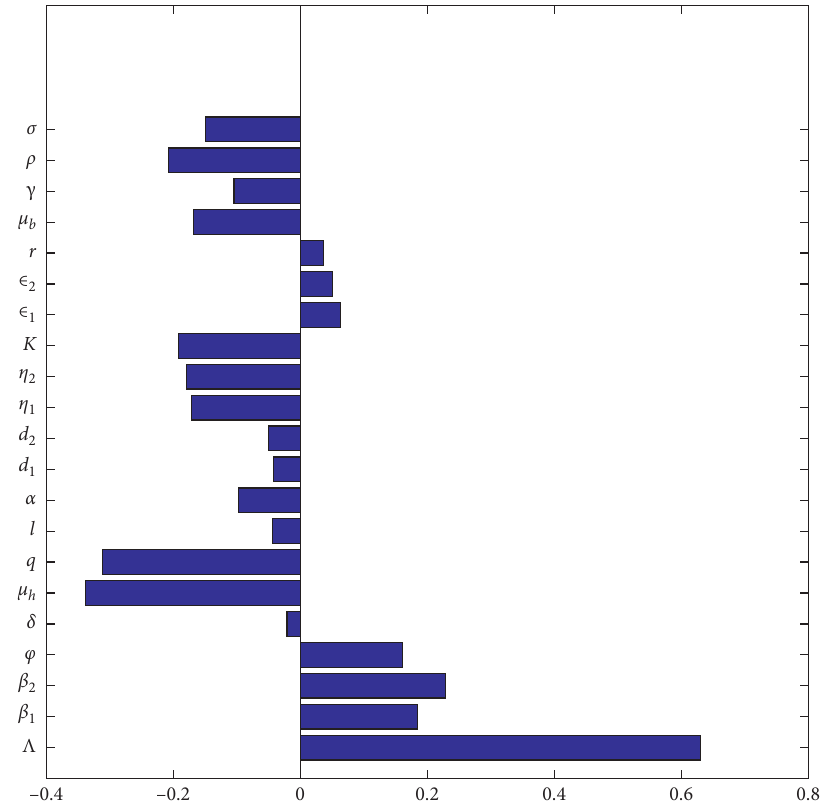
Figure 6: Tornado plots of PRCC of parameters that influence model (2) generated using parameter values in Table 4. Parameters with PRCC > 0 and PRCC < 0 increase and decrease values of R e , respectively. Table 5: Parameters and their sensitivity